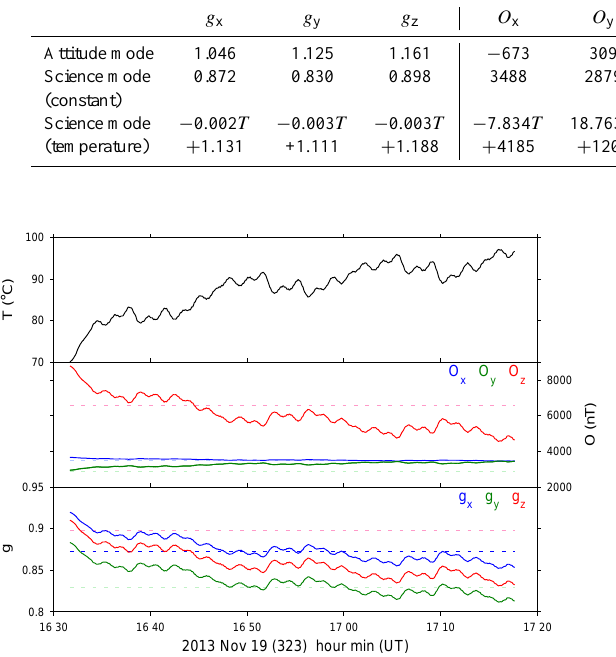
Table 2. List of determined calibration parameters. For temperature calibration, T is in ◦ C. Calibration Attitude mode Science mode